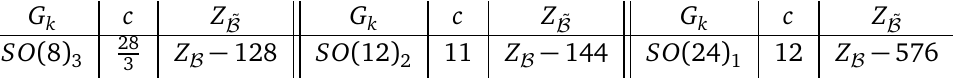
Table 15: List of D-type WZW models satisfying the supersymmetry conditions after the fermion- ization. Each has a non-anomalous (cid:90) symmetry, a subgroup of center symmetry. Since Z B and 2 Z differ by constant, we expect that their fermionic theories have supersymmetric vacua in the (cid:101) B Ramond sector.